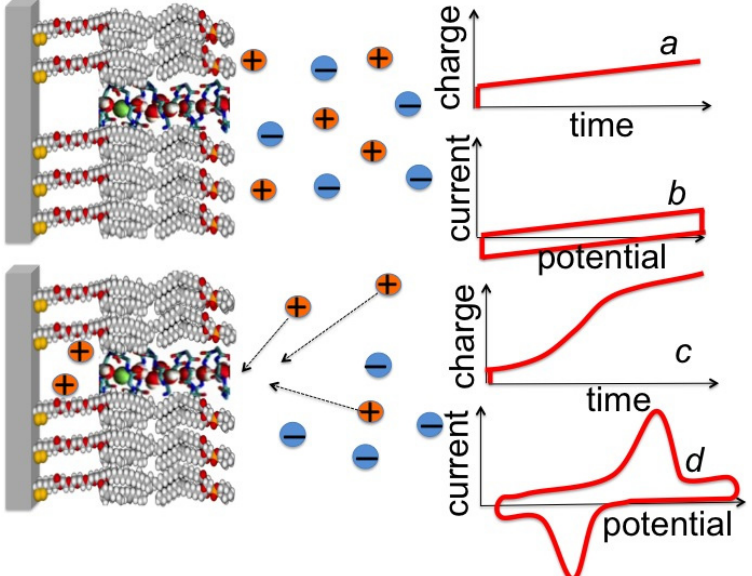
Figure 7. Schematic pictures of a DPTL/DOPC tBLM incorporating a gramicidin channel in the closed state ( top left ) and in the open state ( bottom left ). The typical shape of charge vs. time and current vs. potential curves at a closed ion channel (or in the absence of ion channels) and at an open ion channel is depicted on the right side of the corresponding schematic